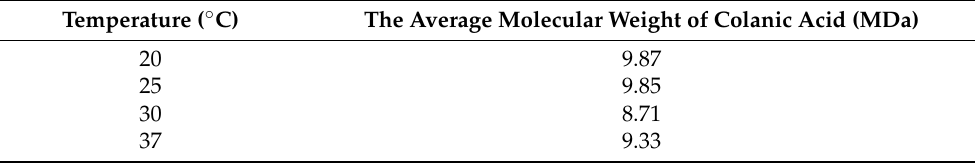
Figure 4. Enhancement of colanic acid production by overexpression of precursors. ( A ) The metabolic pathway of glucose in Escherichia coli K-12 and the structure of colanic acid. ( B ) Colanic acid titers of SP recombinant strains in TBG medium at 30 ◦ C in shake flasks. ( C ) Growth curves of SP recombinant strains in TBG medium at 30 ◦ C in shake flasks. ( D ) Colanic acid titers of SRP recombinant strains in TBG medium at 30 ◦ C in shake flasks. ( E ) Colanic acid titers of the SRP-4 strain in TBG medium at different temperatures in shake flasks. Statistical data analysis was performed with t-texts in SPSS 25.0. p values of <0.05 were considered statistically significant, and statistical significance is indicated as * for p < 0.05 and ** for p < 0.01. Table 2. The molecular weight of colanic acid produced at different temperature by strain